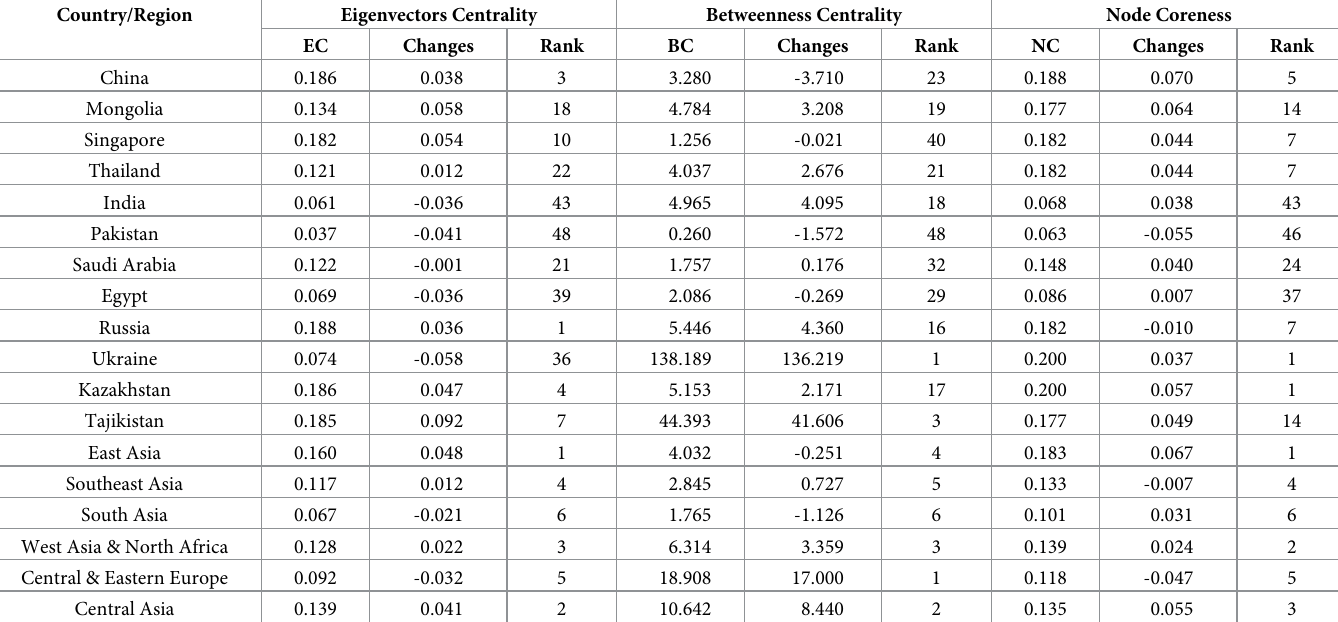
Table 4. Statistics of individual characteristics of main economies during